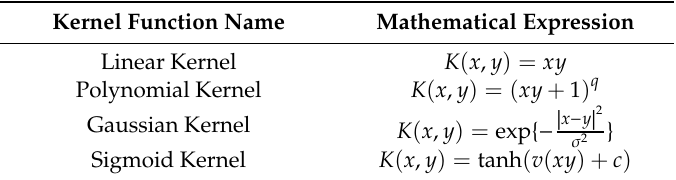
( d ) Figure 8. Some examples of data enhancement. ( a ) Origin image; ( b ) randomly crop; ( c ) change the image contrast; and ( d ) add noise. Table 2. Classification and object detection datasets. Dataset Name